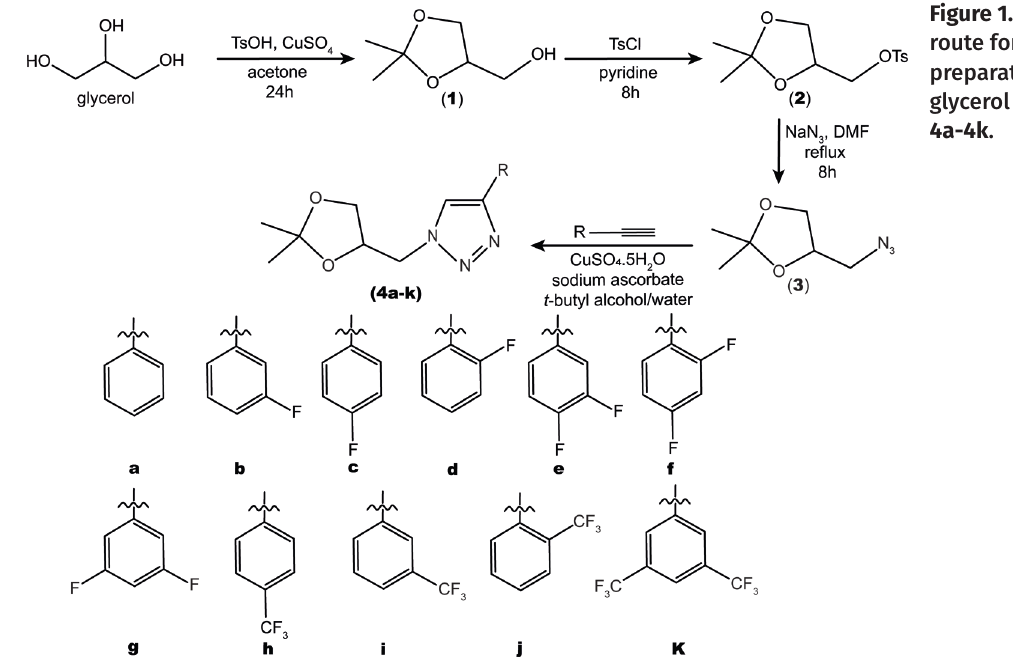
Figure 1. Synthetic route for the preparation